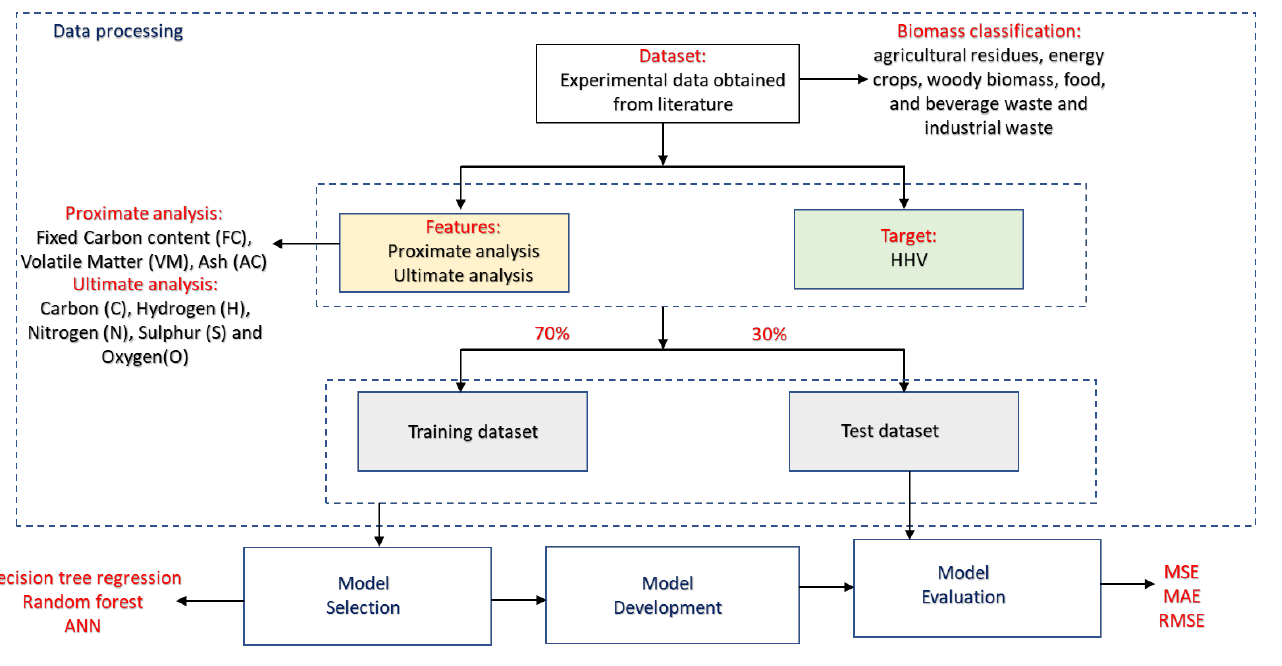
Figure 2. An overview of the methodology used in the study.